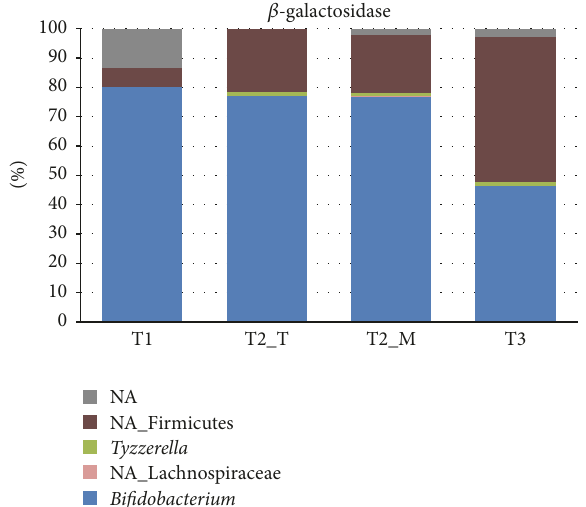
Figure 3: Taxonomic profiles based on expression of the 𝛽 - galactosidase